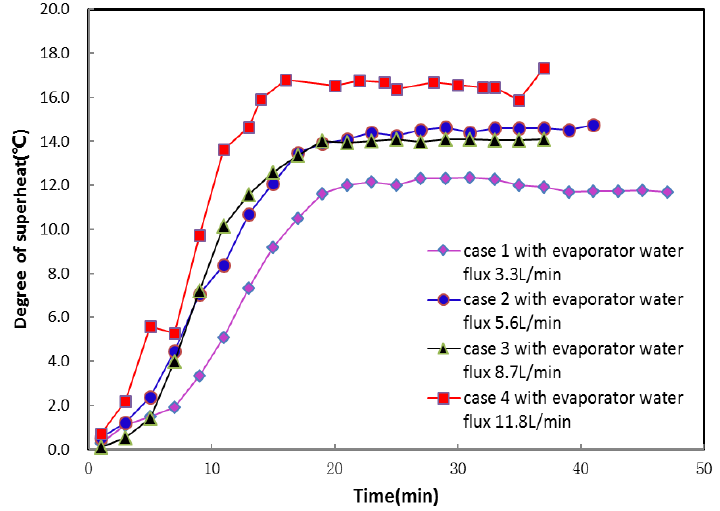
Figure 11. Degrees of compressor discharge superheat at different evaporator water fluxes.